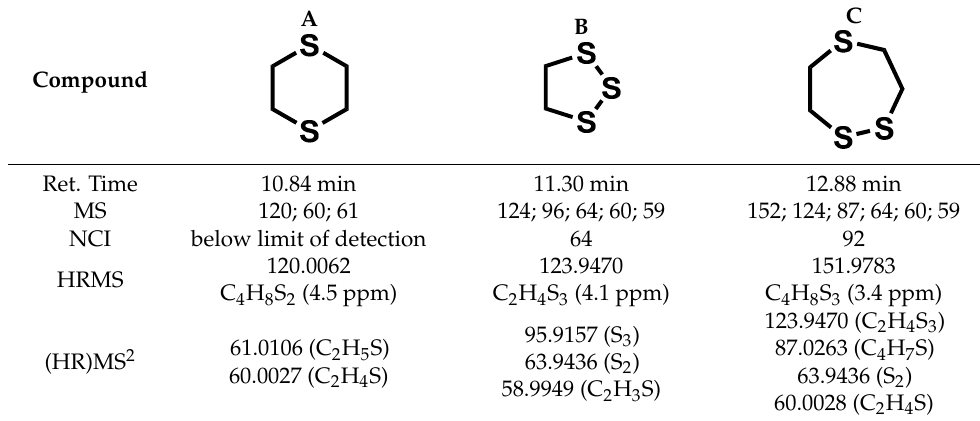
Compound Compound Compound